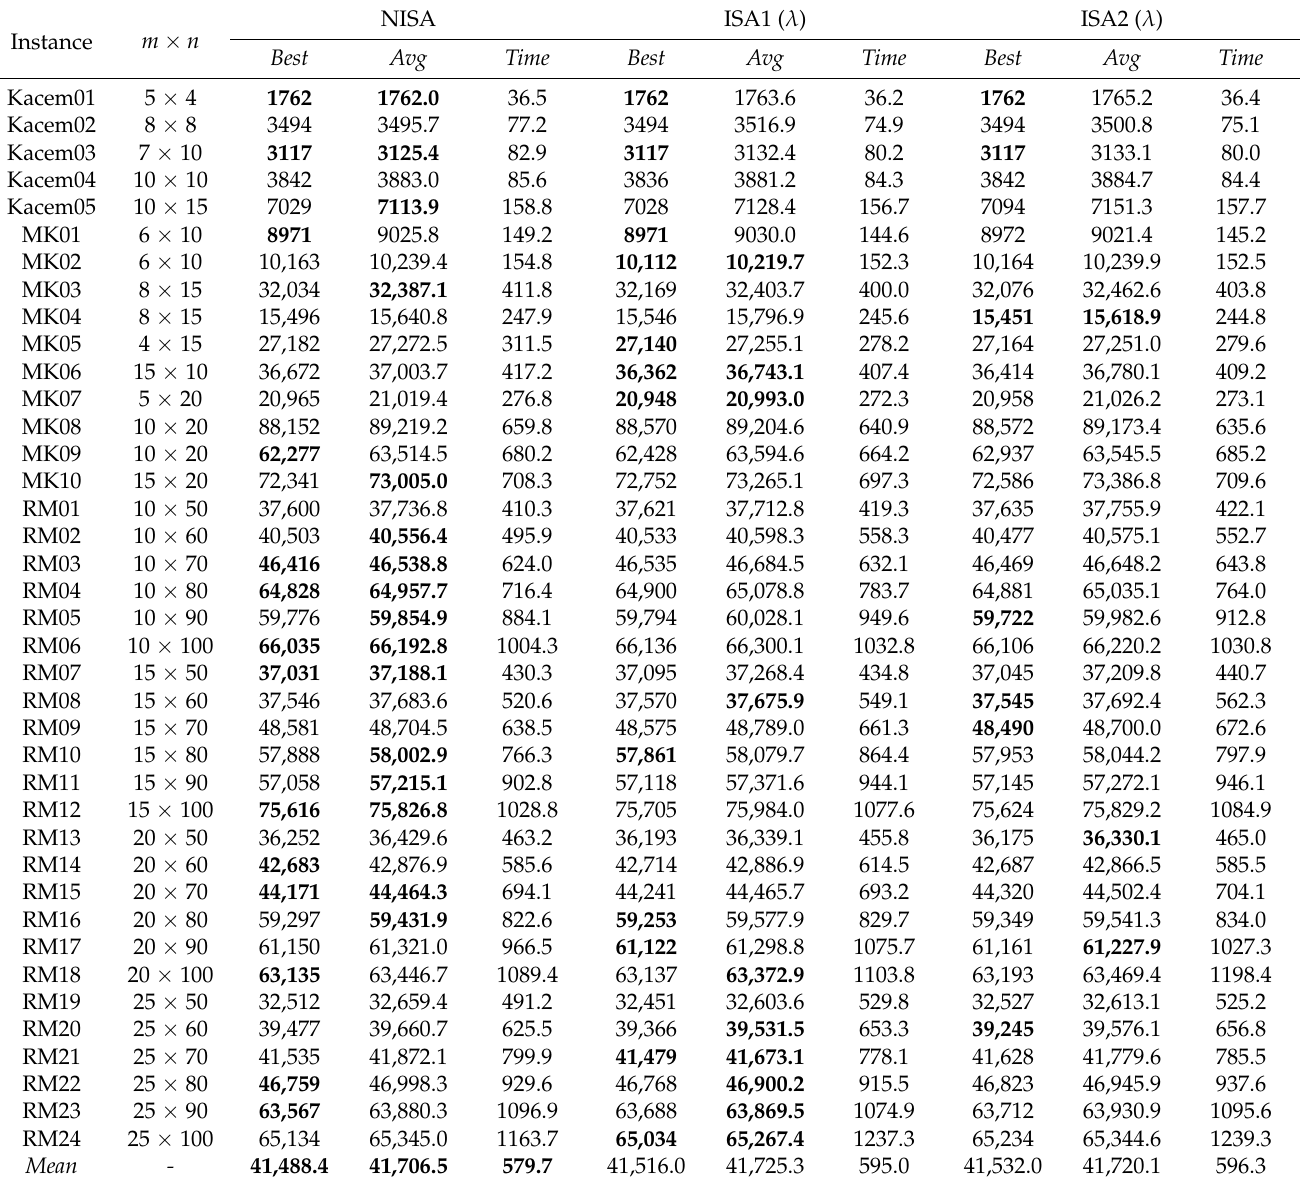
Table 5. Effectiveness analysis of the dynamic adjustment on λ